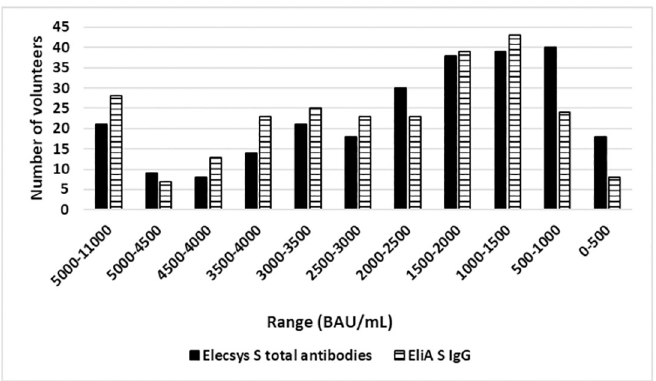
Fig 1. Distribution of the 256 non-infected volunteers through different IgG antibody ranges for both methods used. Volunteers were grouped according to their S protein total antibody and IgG titers (0–500, 500–1000,1000– 1500,1500–2000, 2000–2500, 2500–3000, 3000–3500, 3500–4000, 4000–4500, 4500–500 and 5000–11000